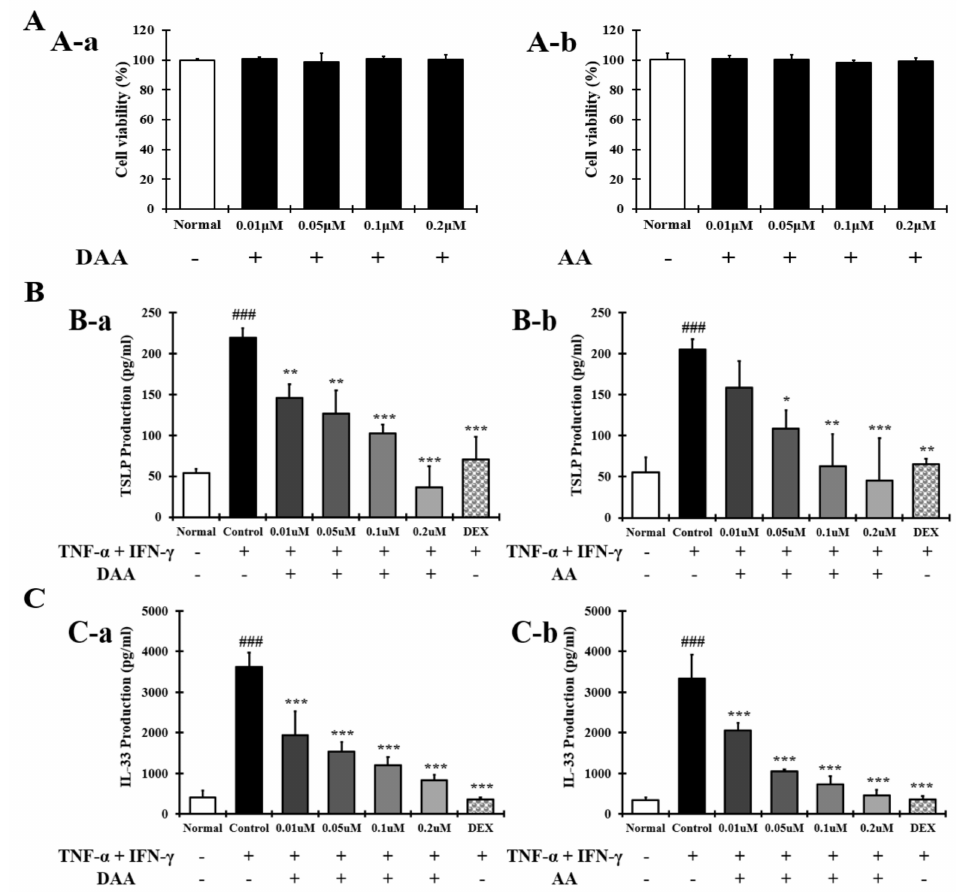
Figure 2. Effect of DAA and AA on HaCaT cell viability and the levels of AD-related cytokines and chemokines in HaCaT cells. ( A ) The viability of HaCaT cells treated with DAA and AA. ( B ) DAA and AA inhibited the secretion of TSLP by HaCaT cells treated with both TNF- α and IFN- γ . ( C ) DAA and AA inhibited the secretion of IL-33 by HaCaT cells treated with both TNF- α and IFN- γ . The production of cytokines and chemokines in the supernatant of HaCaT cells was analyzed by ELISA. The results are expressed as the mean ± SD (n = 4). ### p < 0.001 vs. normal; * p < 0.05, ** p < 0.01 and *** p < 0.001 vs. control; DAA was used at 0.01 µ M, 0.05 µ M, 0.1 µ M, and 0.2 µ M. DEX, the positive control, was used at 0.1 µ